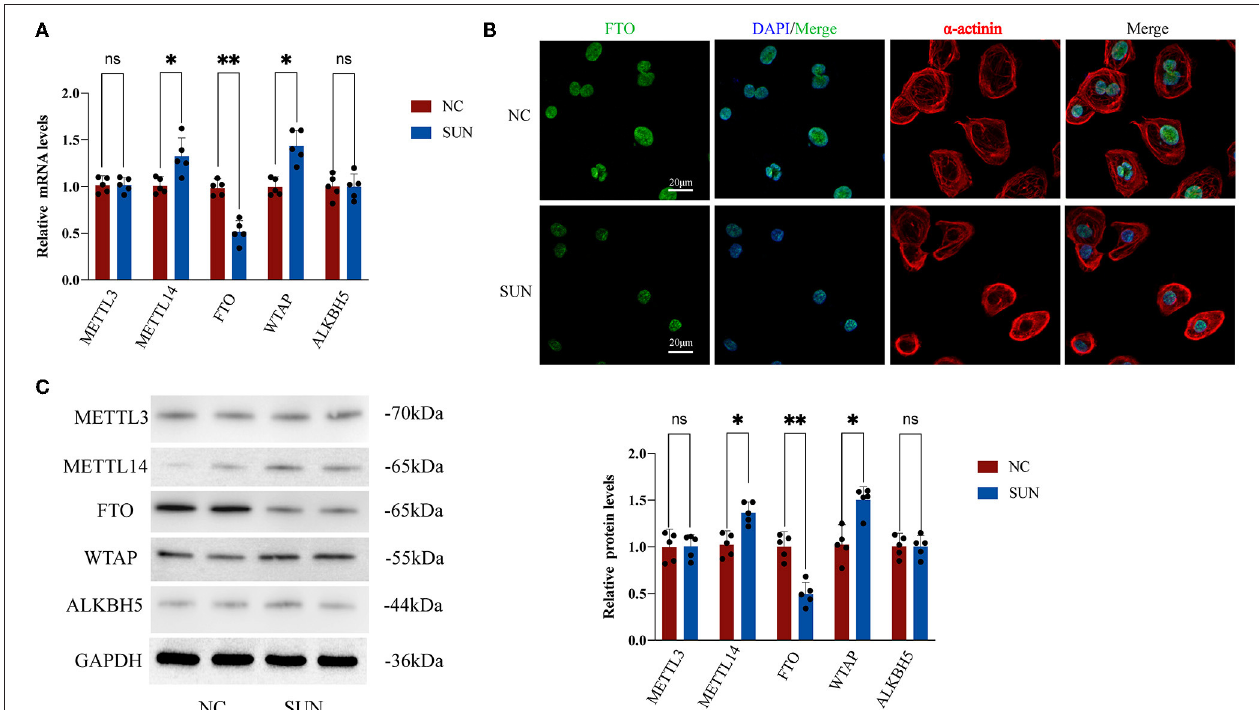
FIGURE 5 | Changes in m 6 A methyltransferase and demethylase expression levels in hiPSC-CMs treated with SUN. (A) Reverse transcription PCR (RT-PCR) of METTL3, ALKBH5, fat mass and obesity-associated protein (FTO), METTL14, and WTAP; the NC group ( n = 5) and the SUN group ( n = 5). (B) The levels of FTO expression in the NC and SUN groups as detected by immunofluorescence. Red denotes α -actinin, green denotes FTO, and blue denotes DAPI. (C) The protein expression levels of methyltransferase and demethylase as detected by Western blot ( n = 5). NS, non-significant, “*” indicates p < 0.05 and “**” indicates p <